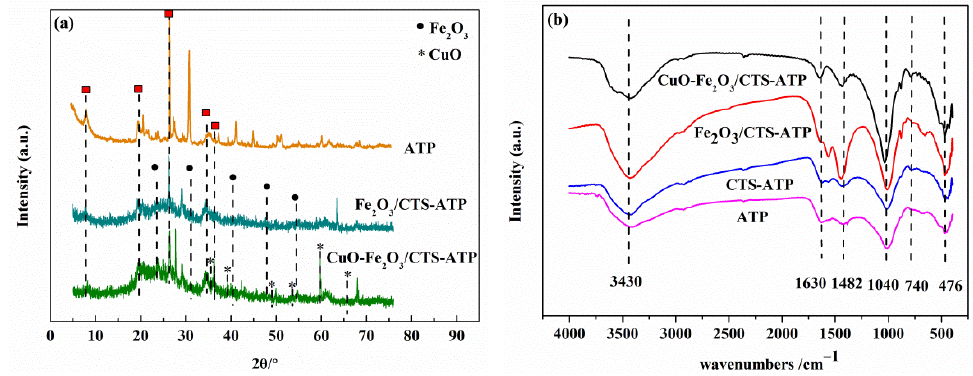
Figure 1. XRD ( a ) and FT-IR ( b ) patterns of the